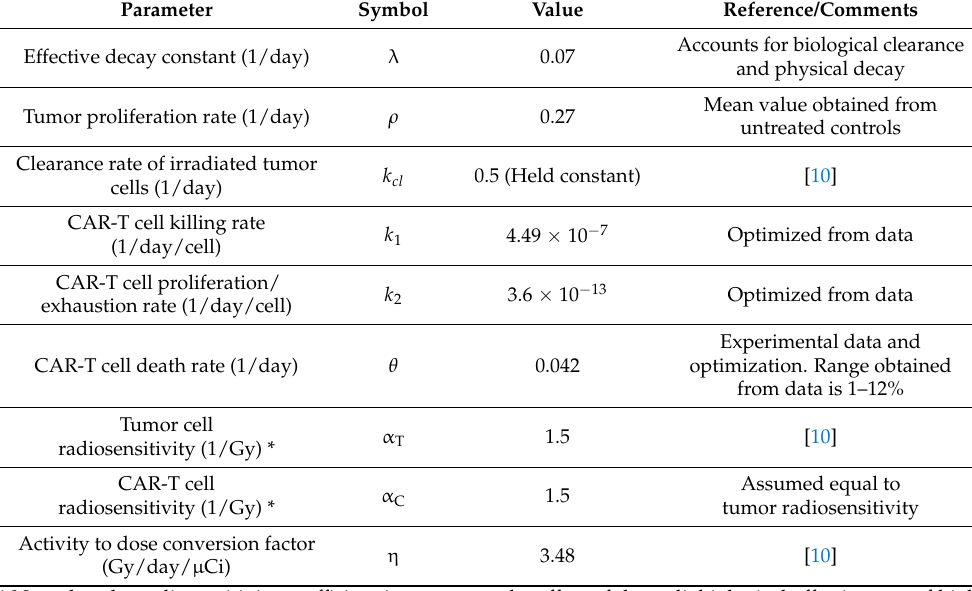
Table 1. Symbols, values, and references for the parameters in the mathematical